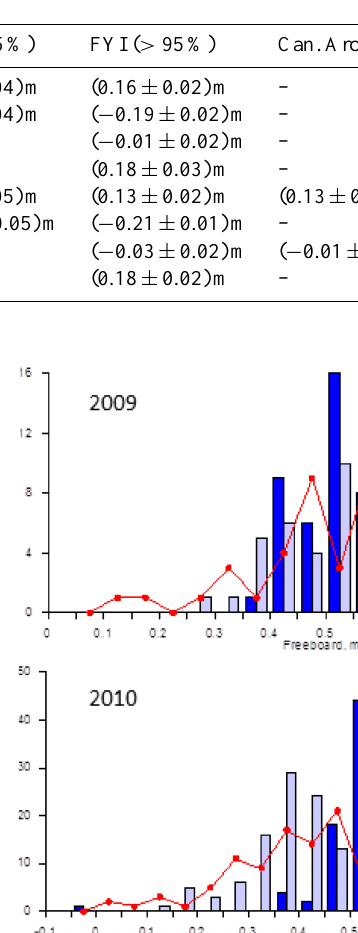
Table 2. Summary of the comparison between OIB, W99 and AMSR-E snow depth in the Arctic Ocean. Absolute values are only given for OIB; all other values are differences. All values are given together with one standard deviation.